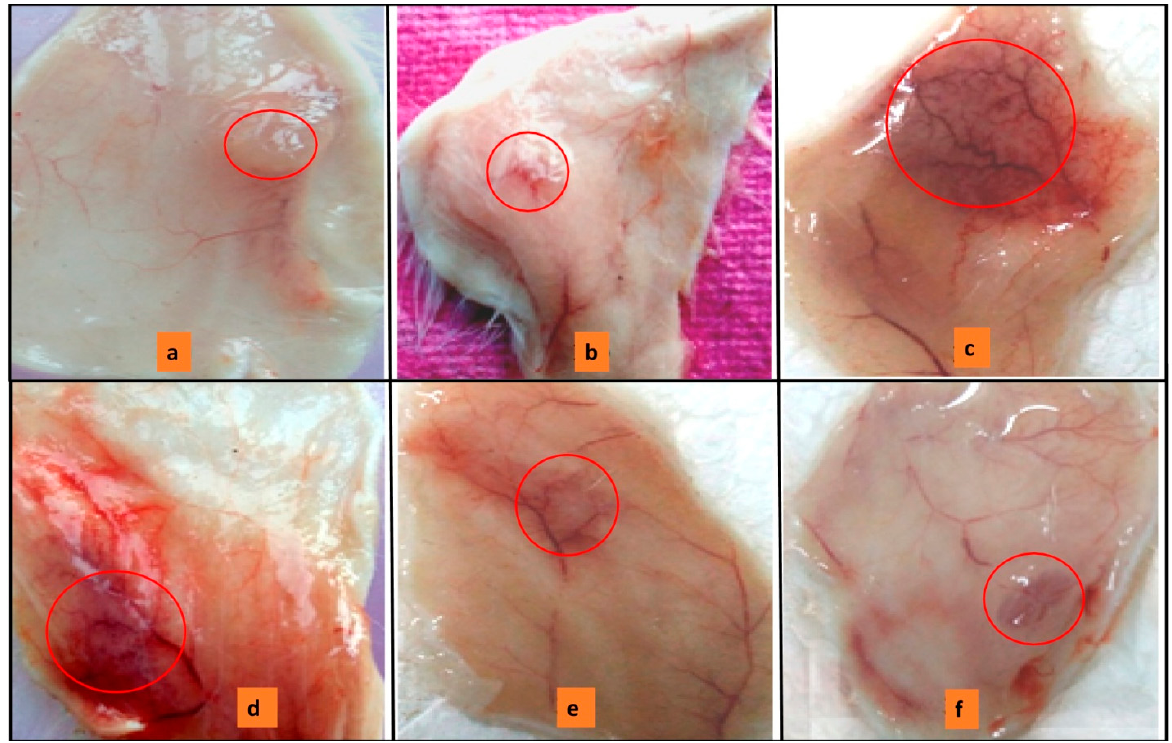
Figure 11. ReducingVR-HC-I mediated hemorrhagic activity by sinapic acid:Mice injected with 10